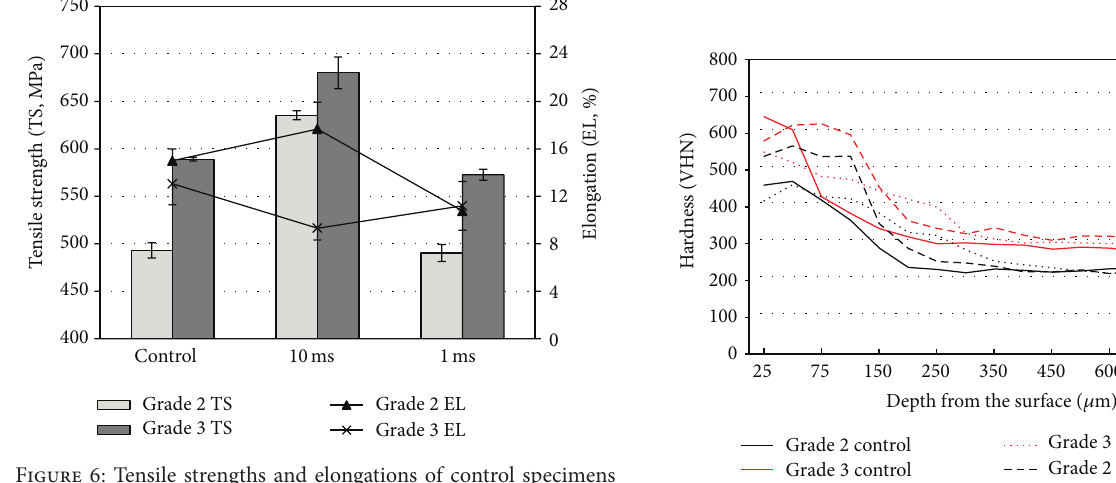
Figure 6: Tensile strengths and elongations of control specimens (grades2and3)andspecimenslaser-treatedwithtwodifferentpulse durations (10ms and 1 ms) at a constant emission current (220 A) and a spot diameter (1.0mm).